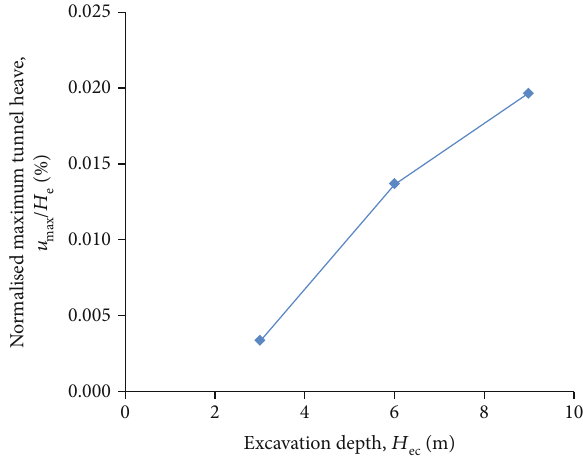
Figure 6: Tunnel heave as a result of di ff erent basement excavation depth in